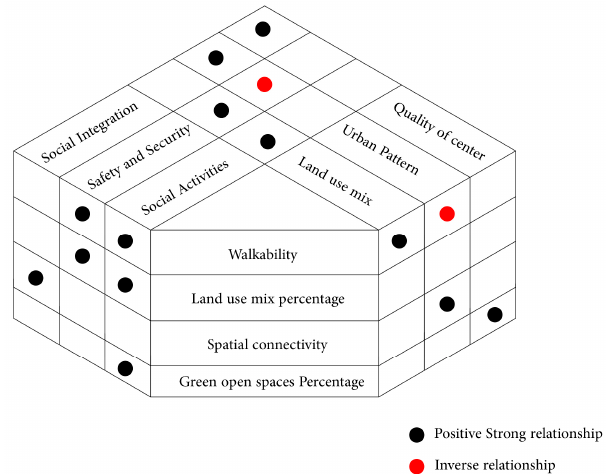
Figure 7. The relationship between the urban form and social aspects after the study